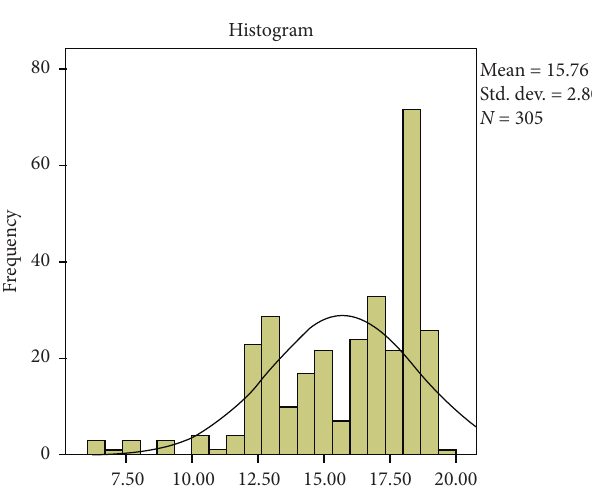
Figure 2: Distribution of gestational week. Table 1: Demographic characteristics of the mothers and event rates of the cities.